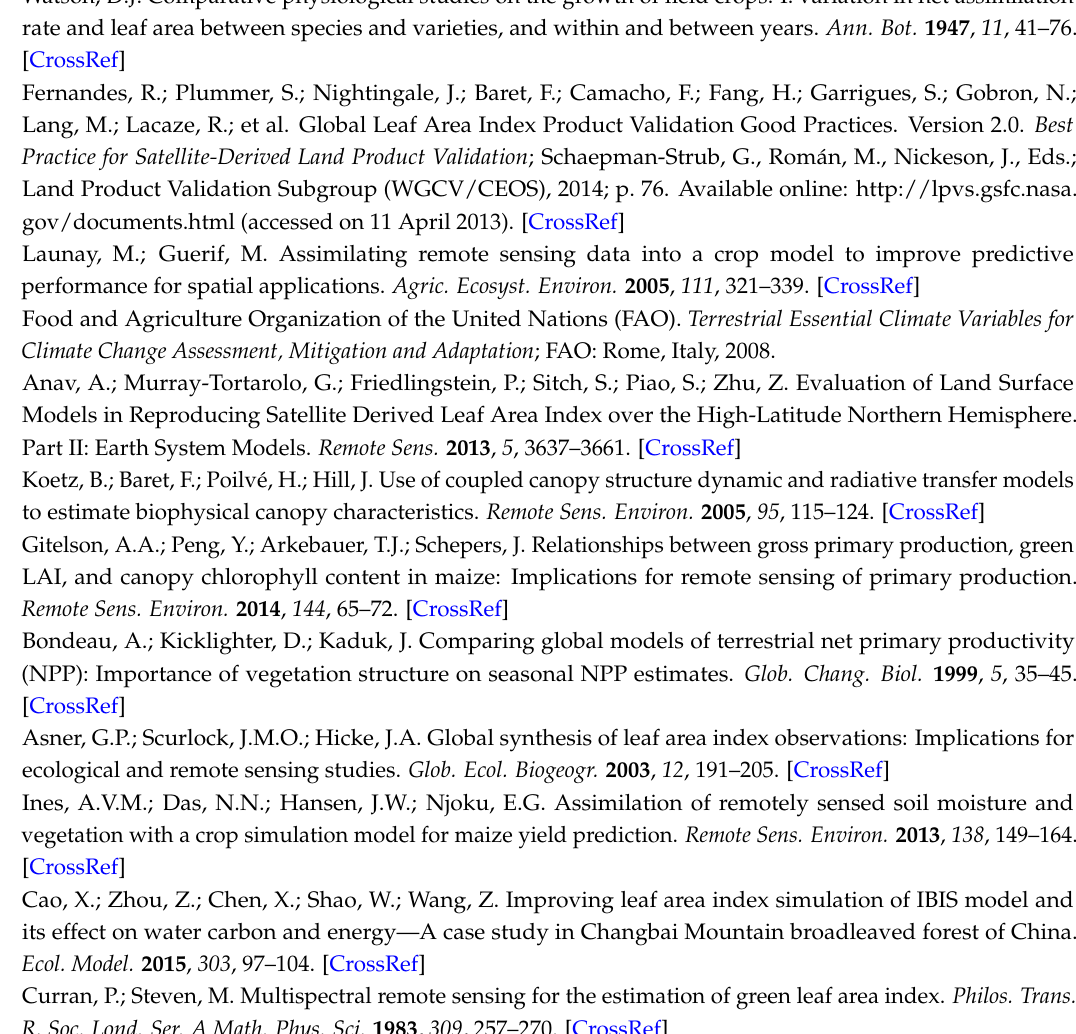
Table S5: Goodness-Of-Fit (GOF) metrics of the global LAI-VI relationships ( LAI “ f p VI q ) for major crops based on three levels of radiometric/atmospheric corrections, Table S6: Best-fit functions for the LAI-VI relationships ( LAI “ f p VI qq ) for major crops based on surface reflectance using the dataset with a complete LAI data range, Table S7: GOF metrics of the global LAI-VI relationships ( LAI “ f p VI q ) for major crops based on three levels of radiometric/atmospheric corrections, Table S8: LAI-EVI and LAI-EVI2 relationships ( LAI “ f p VI q ) based on data transformation and simple linear regression (SLR) with Theil-Sen estimator (the complete-range